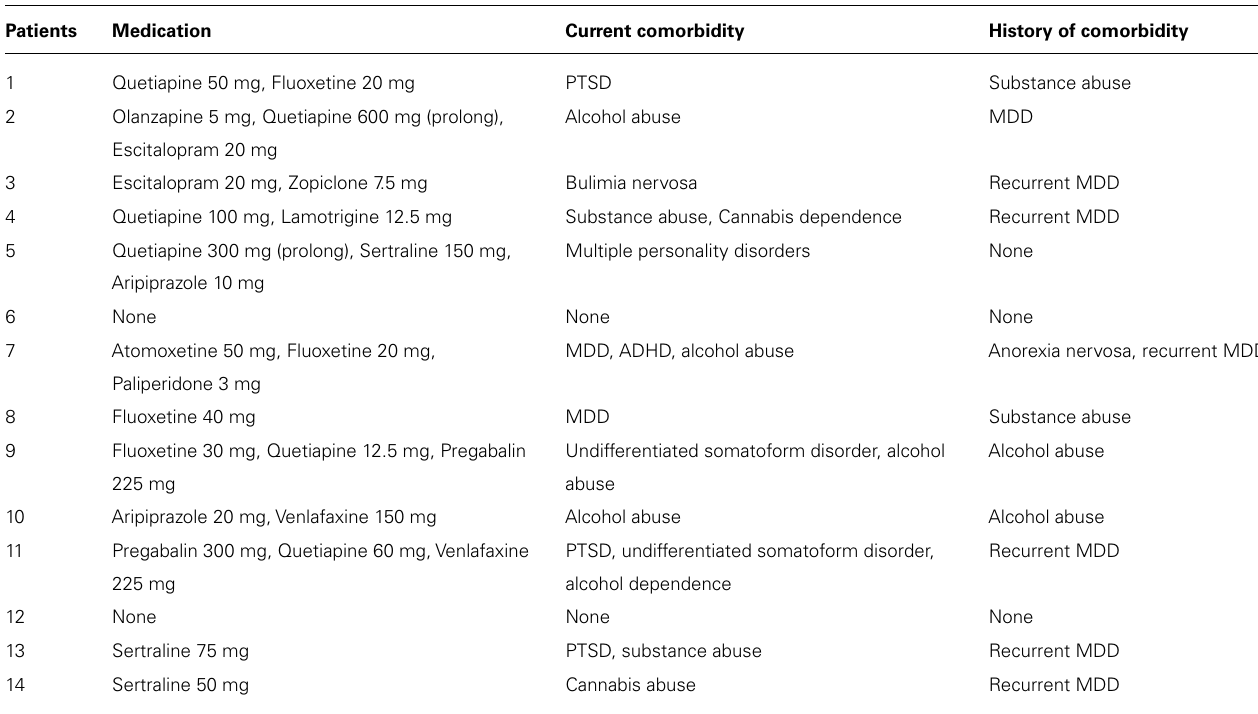
Table 2 | Detailed clinical characteristics of patients with